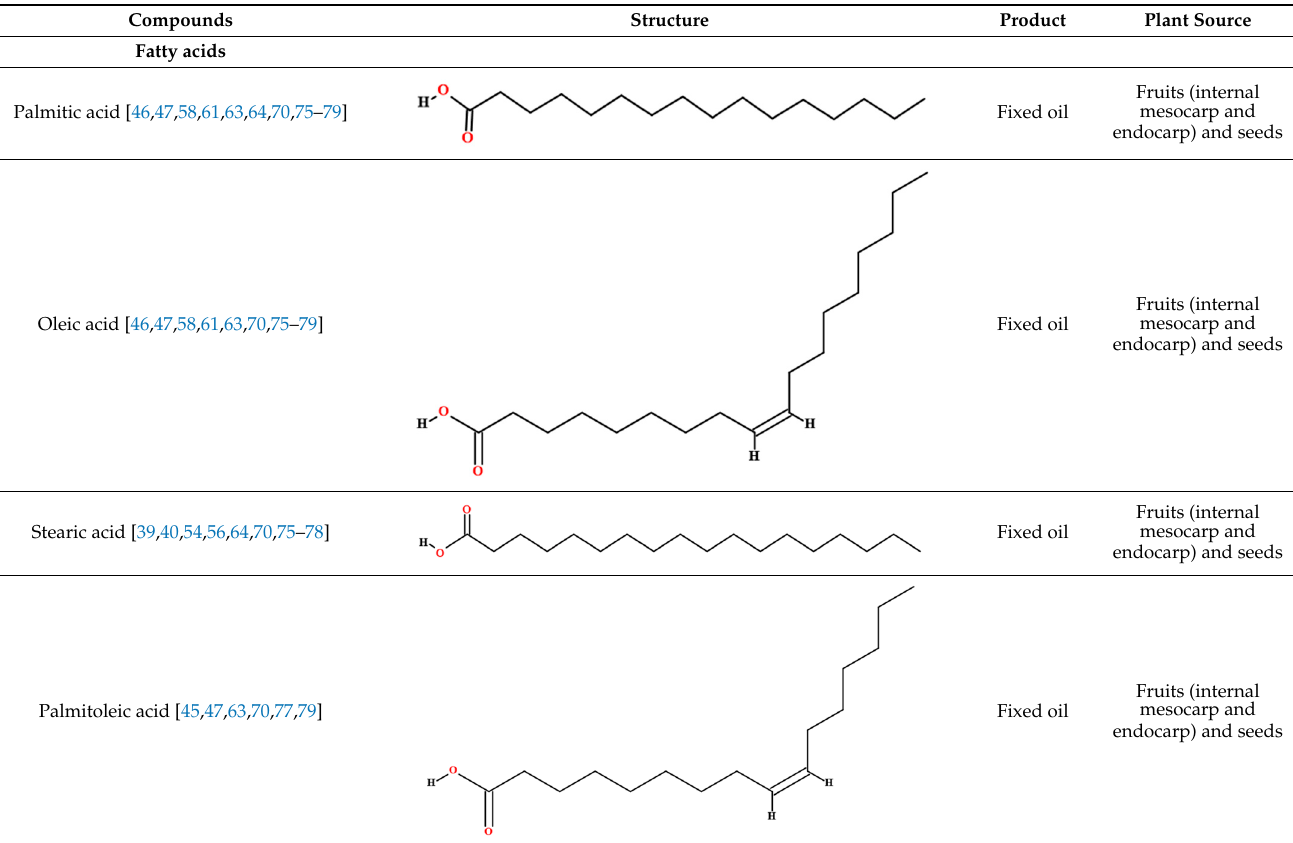
Table 2. Substances identified in Caryocar coriaceum .